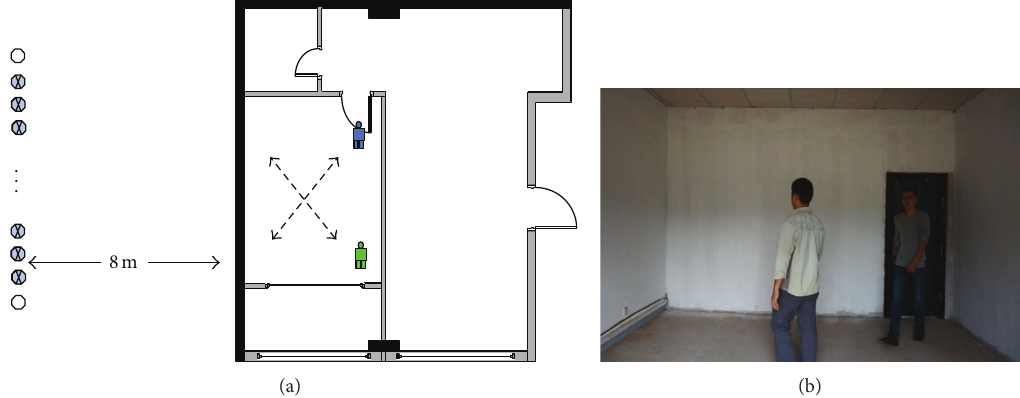
Figure 13: Two persons walked in the bedroom. (a) Track of the movement. (b) Photo of scene when two persons were walking in the bedroom.